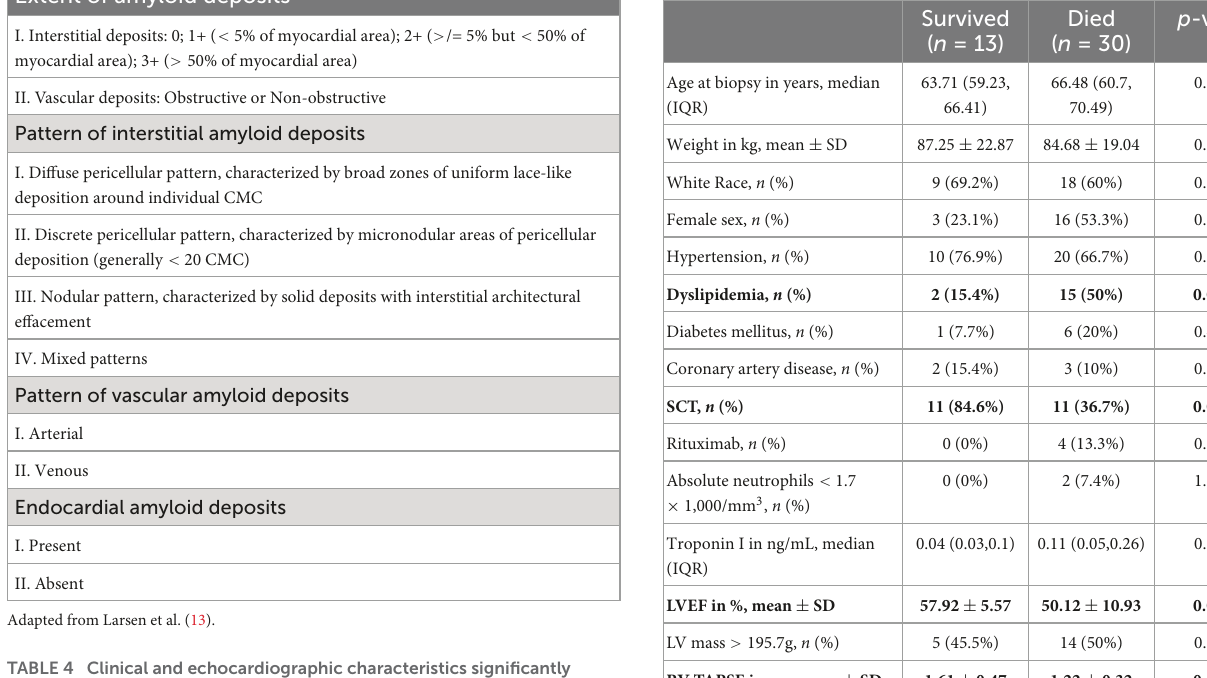
TABLE 4 Clinical and echocardiographic characteristics significantly associated with likelihood of death in the univariate Cox regression analysis.